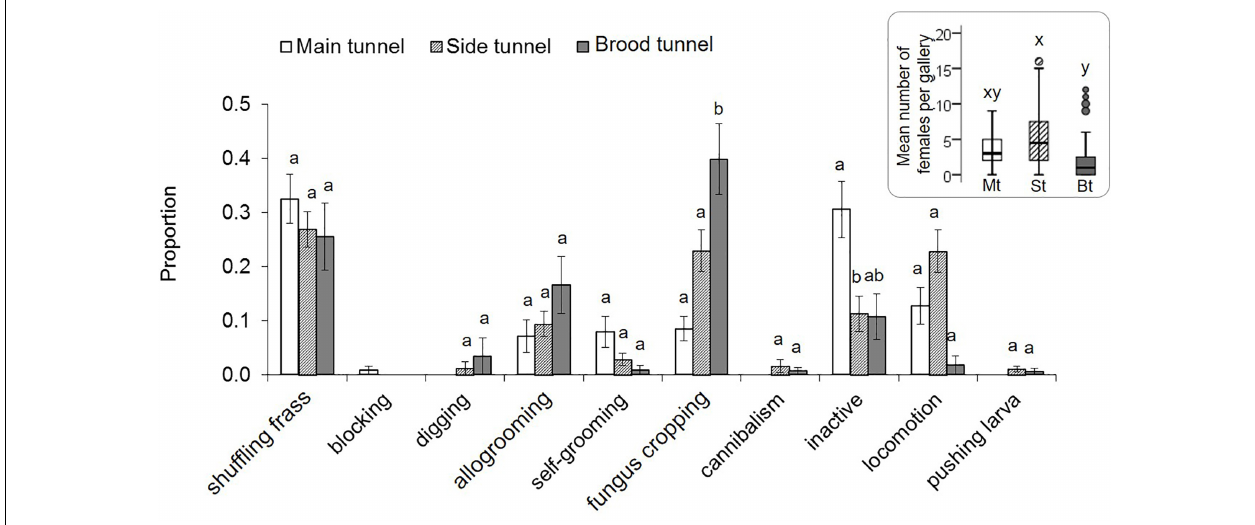
FIGURE 4 | Behaviors of X. affinis adult females in the three gallery compartments. Mean ± SE; different letters denote significant differences ( p < 0.05; for exact values see Supplementary Table S5 ) in pairwise comparisons between compartments. The Mean ( ± SE) numbers of adult females observed in the three compartments are given in the box on the right.